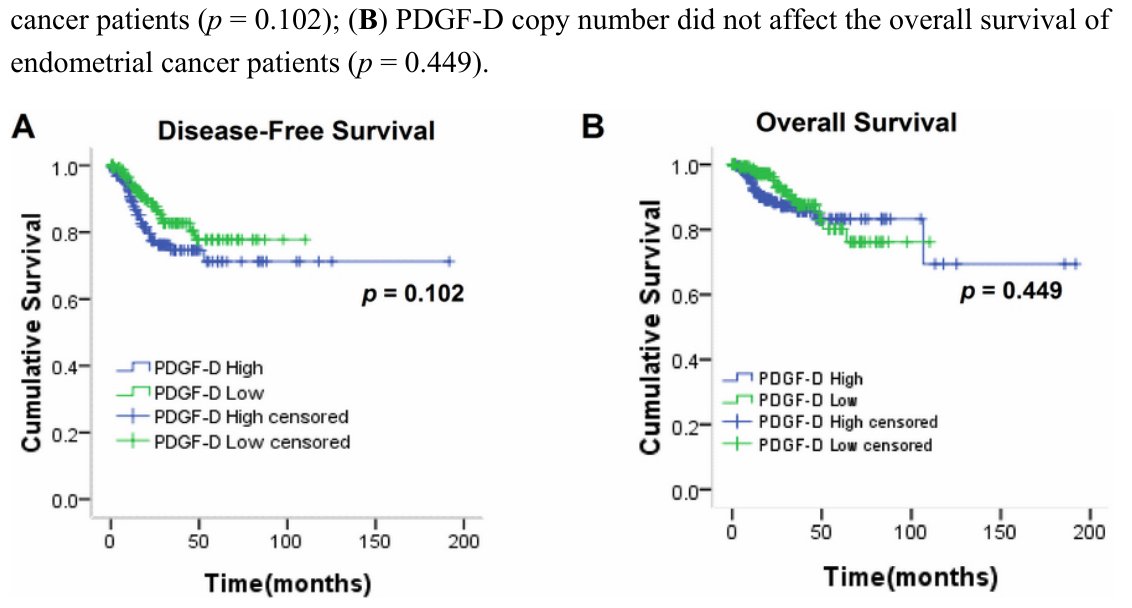
Figure 6. High PDGF-D copy number could predict worse disease-free